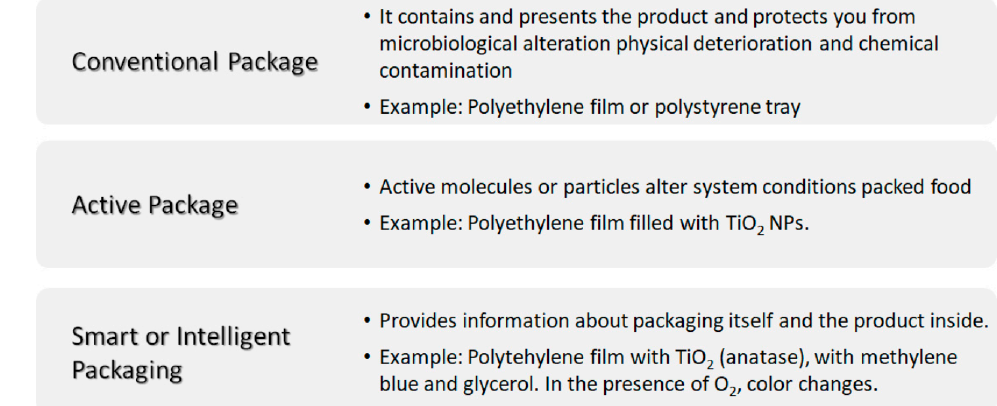
Figure 7. Scheme summarizing the different kinds of packaging: conventional, active and smart or intelligent